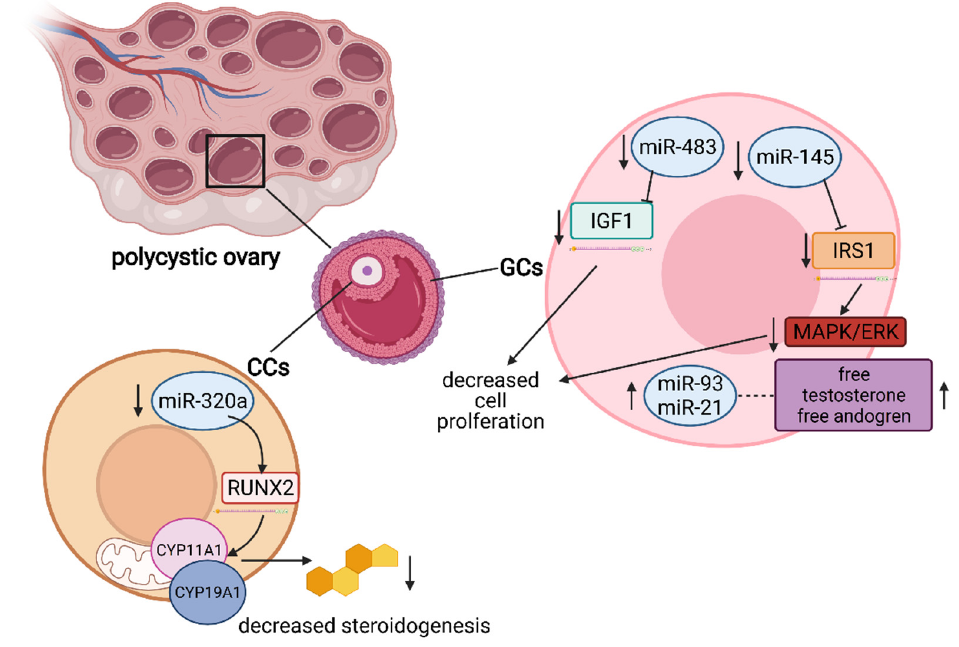
Figure 3. Schematic representation of miRNAs influencing the occurrence of PCOS. MiR-320a is significantly downregulated in CCs, resulting in decreased steroidogenesis due to dysregulation of RUNX2 and CYP11A1/CYP19A1. In GCs, both miR-93 and miR-21 are upregulated and positively correlated with free testosterone and the androgen index, whereas miR-483 and miR-145 are down- regulated. MiR-483 directly targets the IGF1 mRNA, leading to decreased cell proliferation. IRS1 mRNA is a direct target of miR-145, leading to inhibition of the MAPK/ERK signalling pathway, resulting in decreased cell proliferation. Abbreviations—RUNX2: runt-related transcription factor